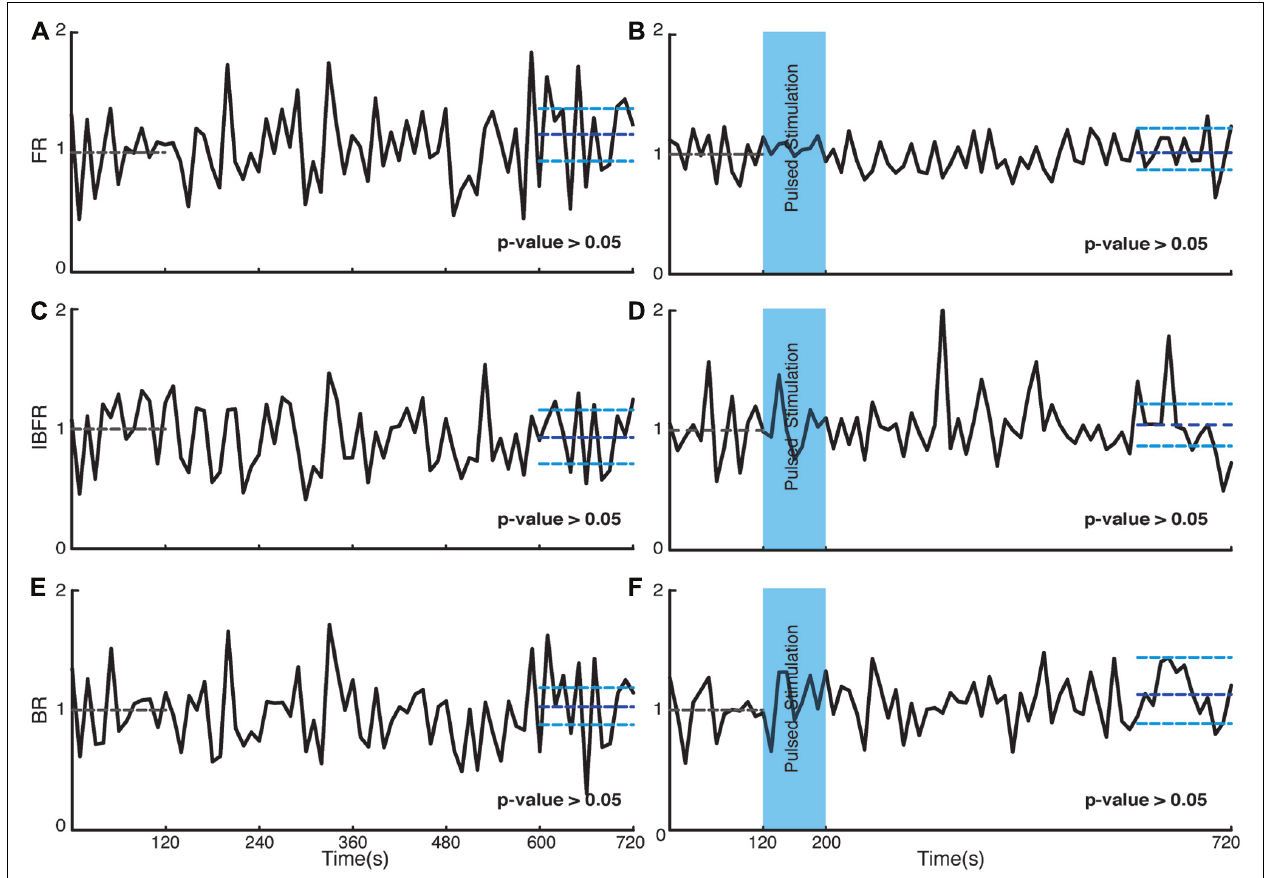
FIGURE 5 | Control experiments. Plots on the left side are corresponding to control experiments of transduced cultures without light stimulation and the plots on the right side are for control experiments on non-transduced cultures stimulated with light. (A,B) Average normalized FR. Here and in the other panels, the dotted gray line marks the mean value of the first 2 min of recording which the activity of the culture is normalized to and the dark blue line marks the mean during the last 2 min of recording. (C,D) Average normalized IBFR. (E,F) Average normalized burst rate. In all plots, the light